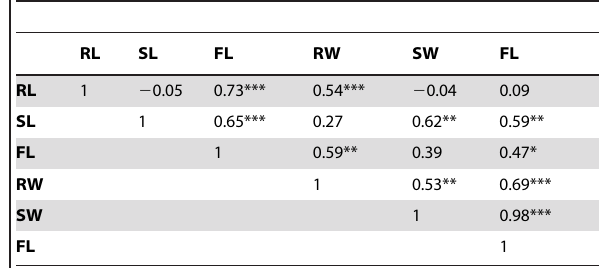
Table 5. Correlation coefficients ( r ) between pairs of traits of seedlings at seedling stage under control.